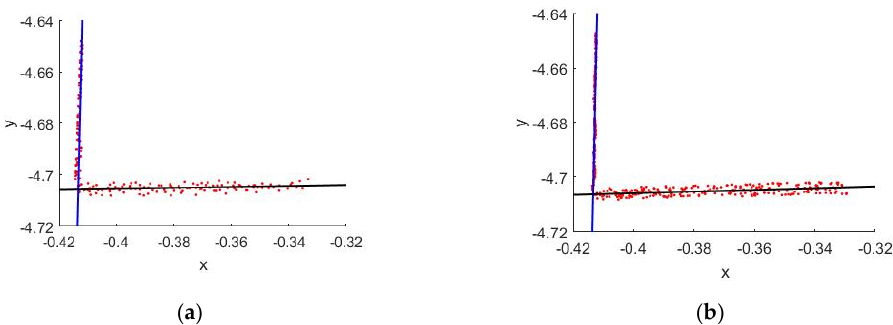
Figure 6. Linear fitted plots of the cross-section of the statue: ( a ) Linear fitted plot of S-origination; ( b ) Linear fitted plot of S-2. Table 5. The parameters of fitted piecewise function for the statue.